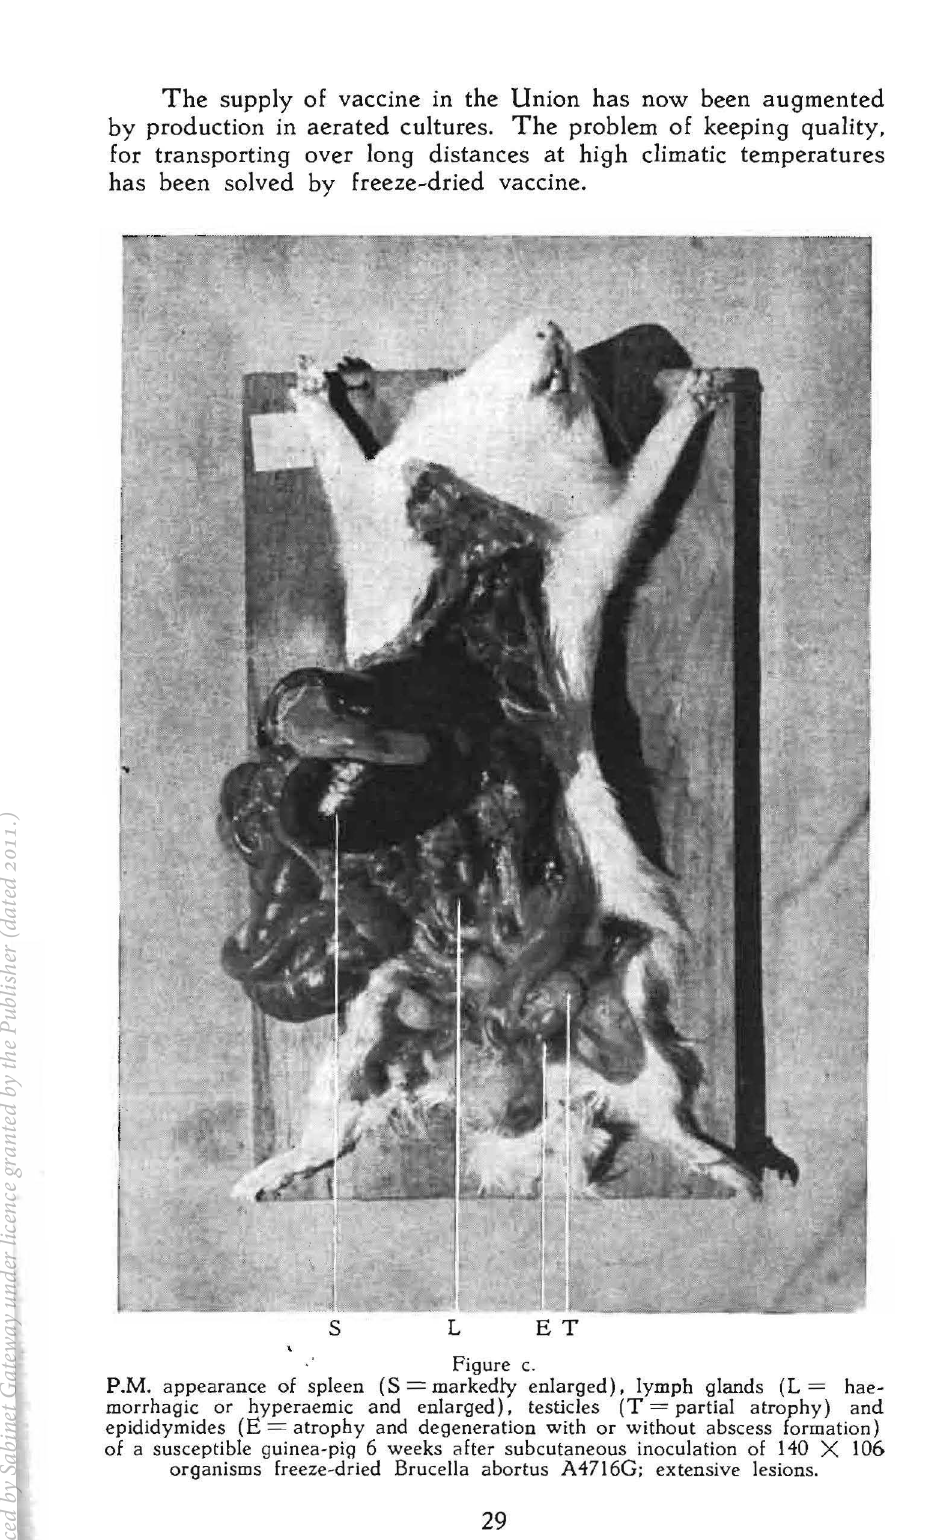
Figure c. P.M. appearance of spleen (S = markedly enlarged). lymph glands (L = hae morrhagic or hyperaemic and enlarged), testicles (T = partial atrophy) and = epididymides (E atrophy and degeneration with or without abscess formation) of a susceptible guinea-pig 6 weeks after subcutaneous inoculation of 140 X 106 organisms freeze-dried Brucella abortus A4716G; extensive lesions.